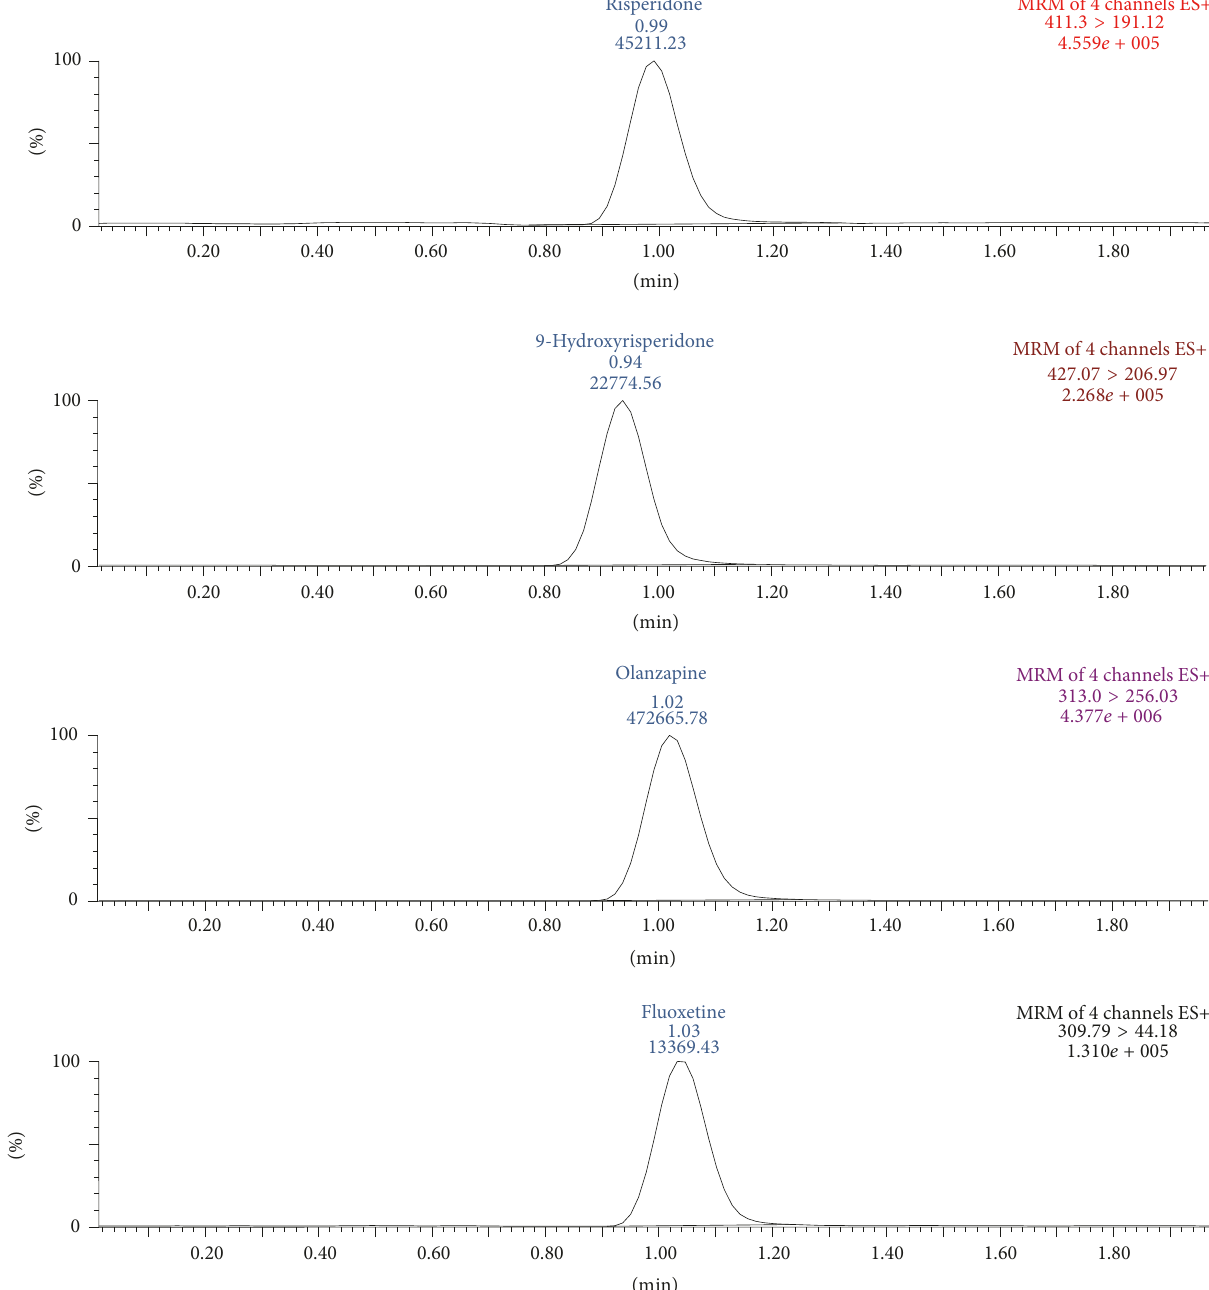
Figure 4: MRM chromatogram of plasma spiked with 100.0 ng/mL of FLX, RIS, and 9-OH-RIS and 1200.0 ng/mL of the IS (OLA).